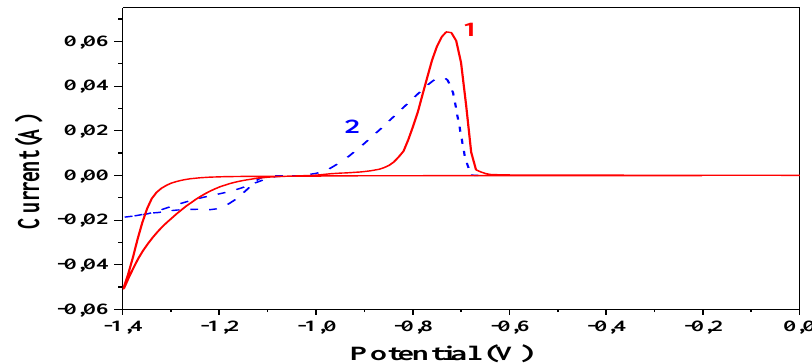
Figure 8. CVA curves of ordinary Zn and of Zn-PANI / SiO 2 coatings 1—Zn; 2—Zn-PANI / SiO 2 .